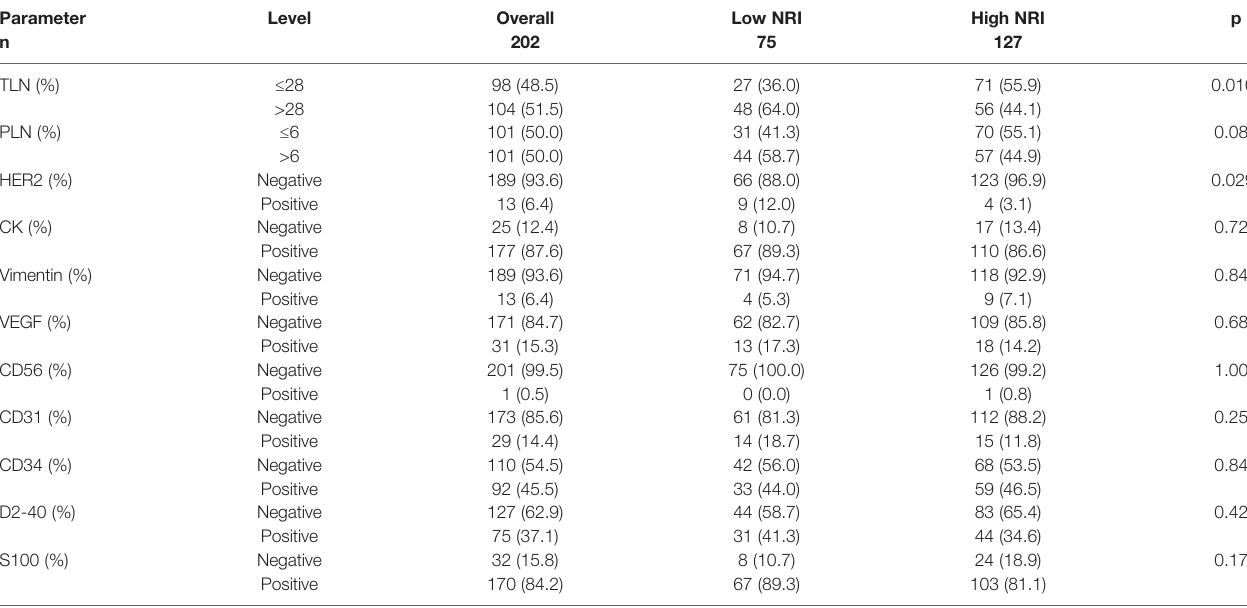
TABLE 3 | The relationships of NRI with pathological parameters. Parameter